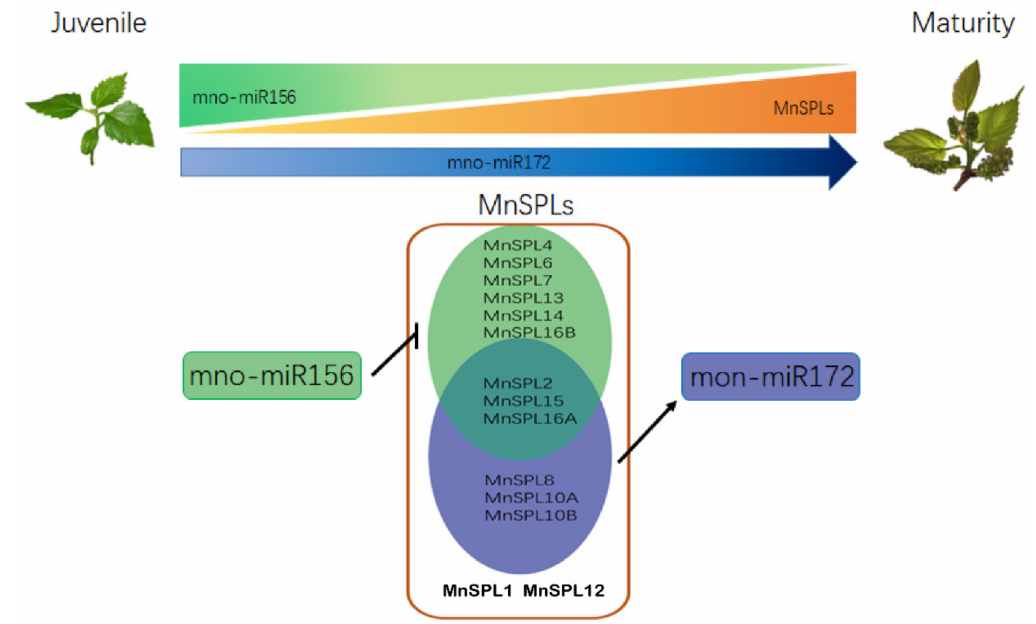
Figure 8. The molecular mechanism of miR156 in mulberry development. The larger area and darker color indicate higher gene expression